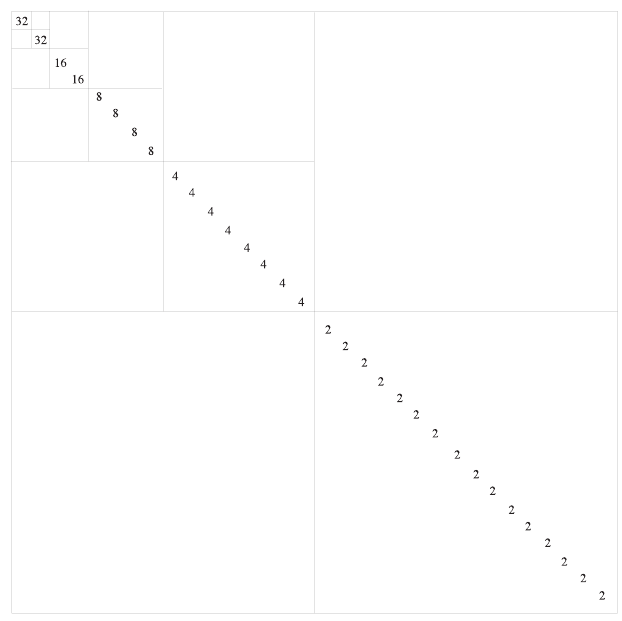
(cid:4) 32 used for for N i;j i (cid:8) N wavelet- i i . w